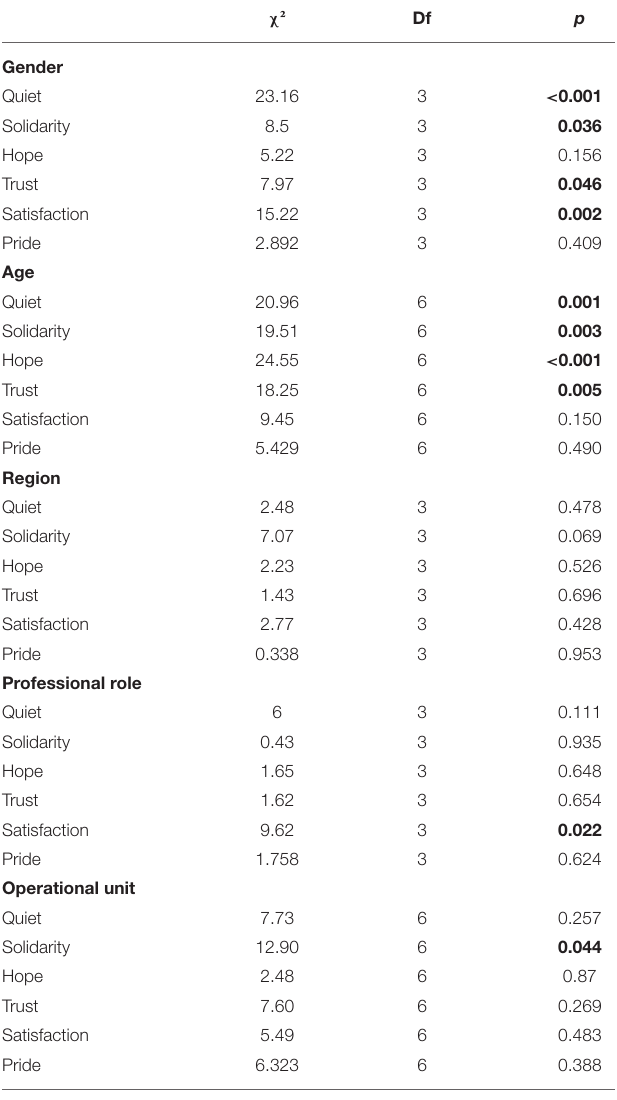
TABLE 6 | Multinomial logistic regressions omnibus Likelihood Ratio for psychological impact category encompassing positive feelings and demographic factors (gender, age, geographical region, professional role, operational